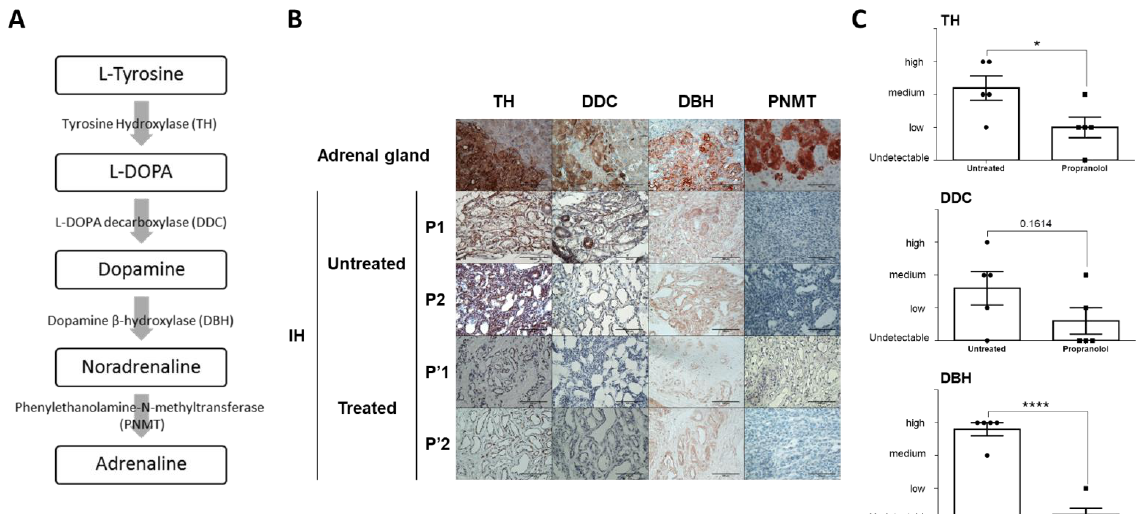
Figure 2. Enzymes implicated in catecholamine biosynthesis pathway are expressed in IH tissues and their expressions are decreased by propranolol treatment. ( A ) Catecholamine biosynthesis pathway is shown. ( B ) All catecholamine biosynthesis enzymes except PNMT are expressed in IH tissue, enabling them to synthesize dopamine and NA. Expression levels of these enzymes are reduced with propranolol treatment. The adrenal gland is used as a positive control. Expression levels of catecholamine biosynthesis enzymes in untreated patients are different from treated patients. Two representative pictures of 5 untreated patients and 5 propranolol-treated patients are shown. Scale bar size is 100 µm. NA: noradrenaline, IH: infantile hemangioma. ( C ) Immunostained sections were scored considering the intensity of TH, DDC and DBH in a blinded manner for 5 untreated patients and 5 propranolol-treated patients. Data are represented as mean ± SEM, * p < 0.05, **** p < 0.0001.